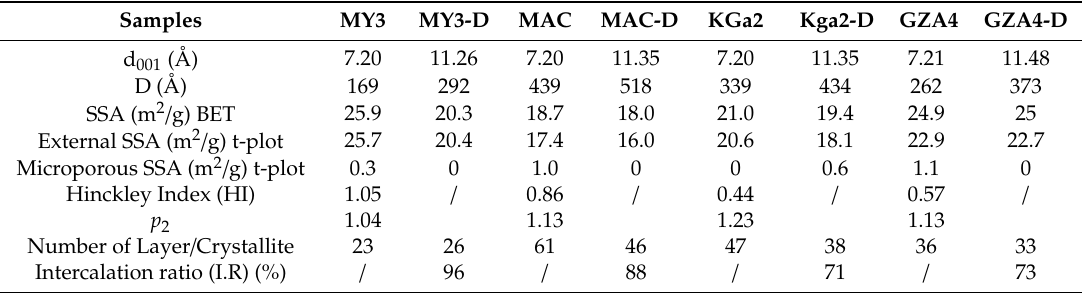
Table 1. Crystallite size (D); specific surface area (SSA); Hinckley index; number of layers per crystallite (NL / Crystallite) and intercalation